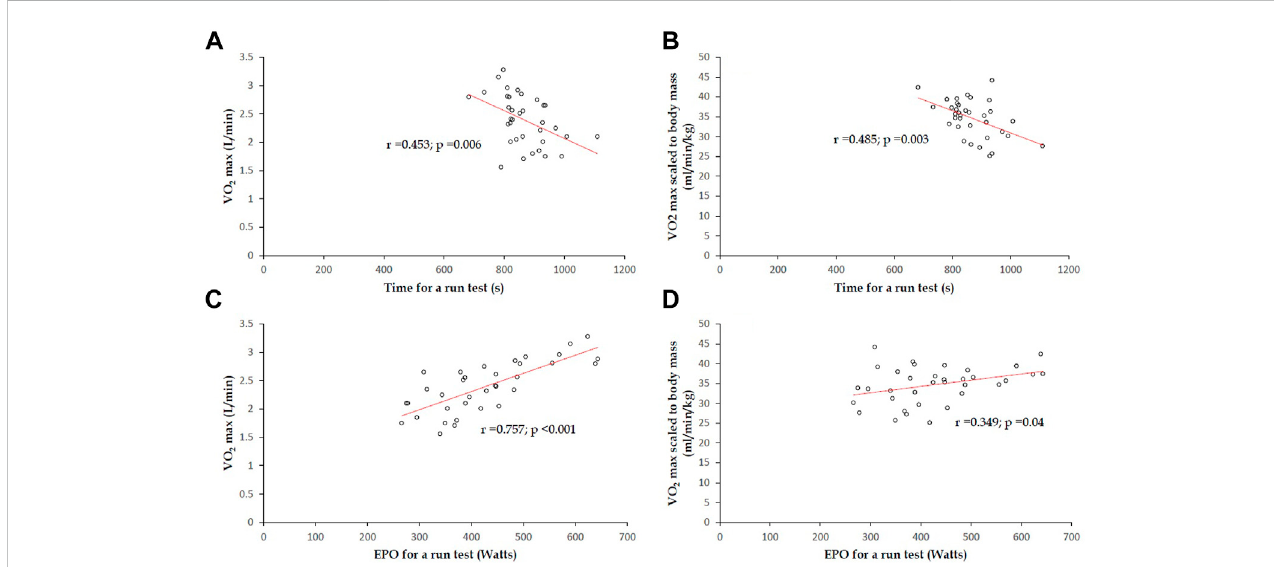
FIGURE 4 In35participantswithbodymassindex < 27.5 kg/m 2 ,forbotha3000-mrun fi eldtestandCPET: (A) correlationcoef fi cientoftimefora3000-mrun fi eld test against VO 2 max (L/min) was estimated to be 0.453 ( p = 0.006); (B) correlation coef fi cient of time for a 3,000-m run fi eld test against VO 2 max scaled to body mass (kg) was estimated to be 0.485 ( p = 0.003); (C) correlation coef fi cient of EPO for a 3,000-m run fi eld test with VO 2 max (L/min) was 0.757 ( p < 0.001). (D) correlation coef fi cient between EPO for a 3,000-m run fi eld test and VO 2 max (L/min) scaled to body mass was 0.349 ( p =